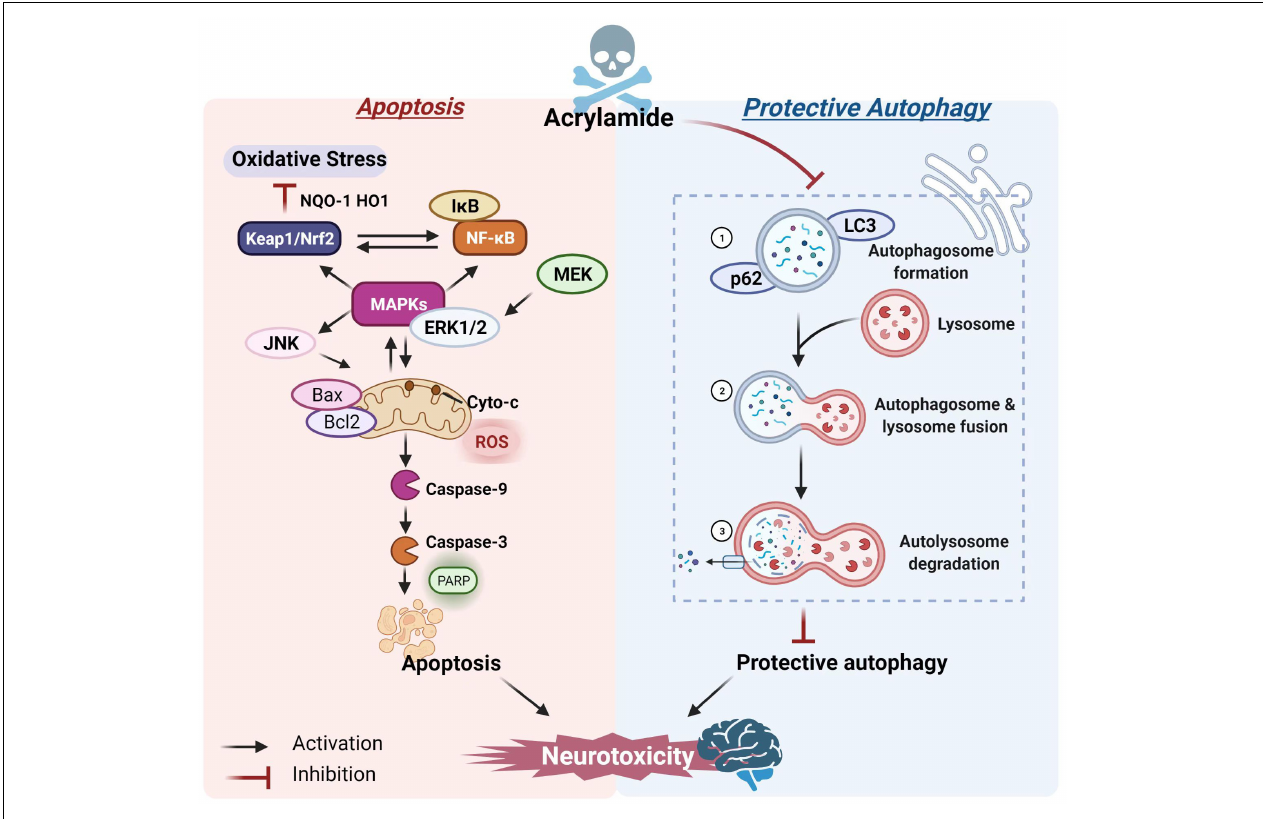
FIGURE 2 | The potential mechanism of ACR-induced apoptosis and autophagy.